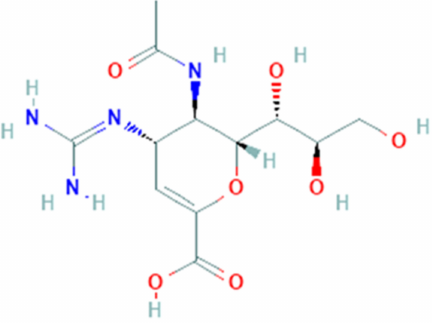
Figure 9. Chemical structure of